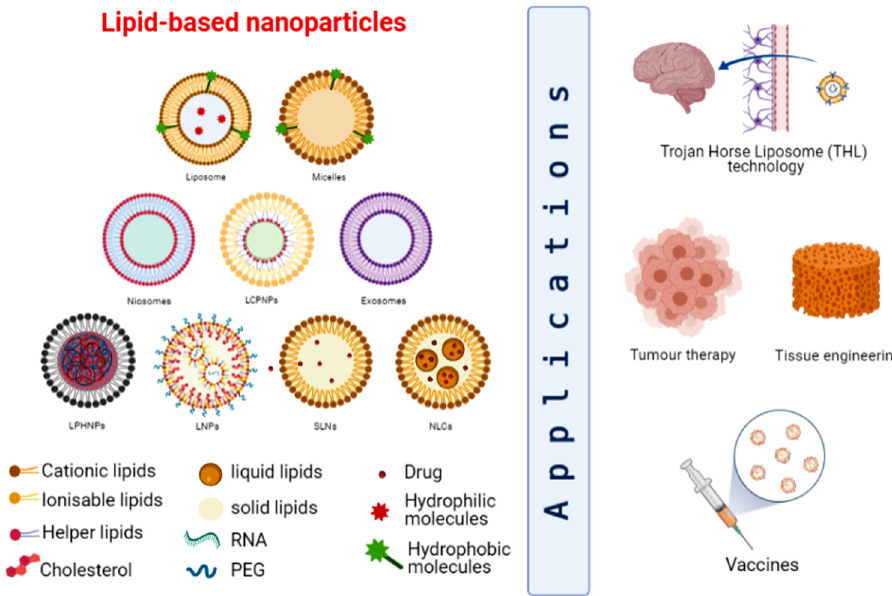
Figure 8: LNPs including liposomes, micelles, exosomes, niosomes, solid lipid nanoparticles ( SLNs ) , nanostructured lipid carriers ( NLCs ) , lipid hybrid nanoparticles ( LPHNPs ) , and LCPNPs and their application in biomedical research. Liposomes can encapsulate hydrophilic molecules in the inner core, while the hydrophobic ones are associated with the phospholipid membranes; micelles can link lipophilic molecules in the hydrophobic core; LNPs can encapsulate nucleic acid like RNA. SLNs are composed by solid lipids, while NLCs by both solid and liquids. Thanks to their characteristics, LNPs are amply studied in Trojan Horse Liposome ( THL ) technology for NDs, cancer therapy, tissue engineering, and in vaccine